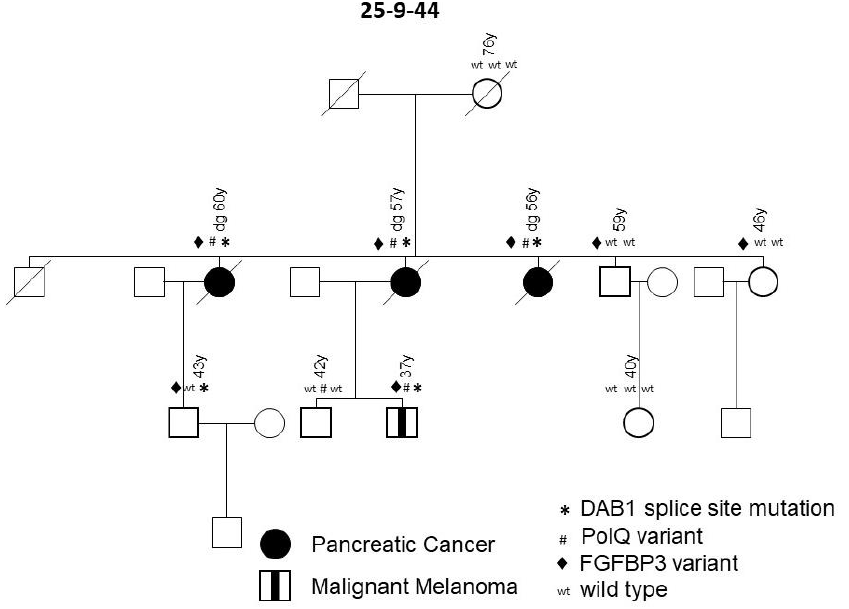
Figure 3. FPC family with variants in DAB1 , PolQ and FGFBP3 genes. Diagonal lines indicate deceased individuals.